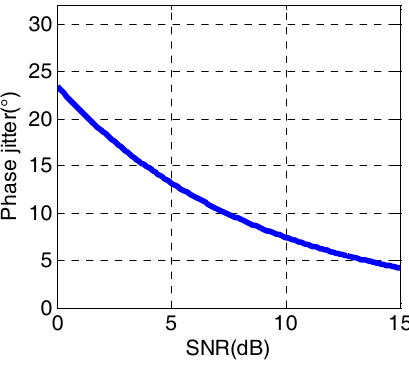
Figure 17. The phase jitter of PLL.